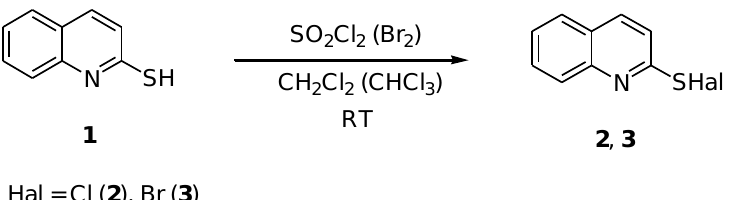
Scheme 3. The simple and efficient method for generation of 2-quinolinesulfenyl chloride 2 and bromide 3 by the action of sulfuryl chloride or bromine on 2-mercaptoquinoline 1 in methylene chloride or chloroform.